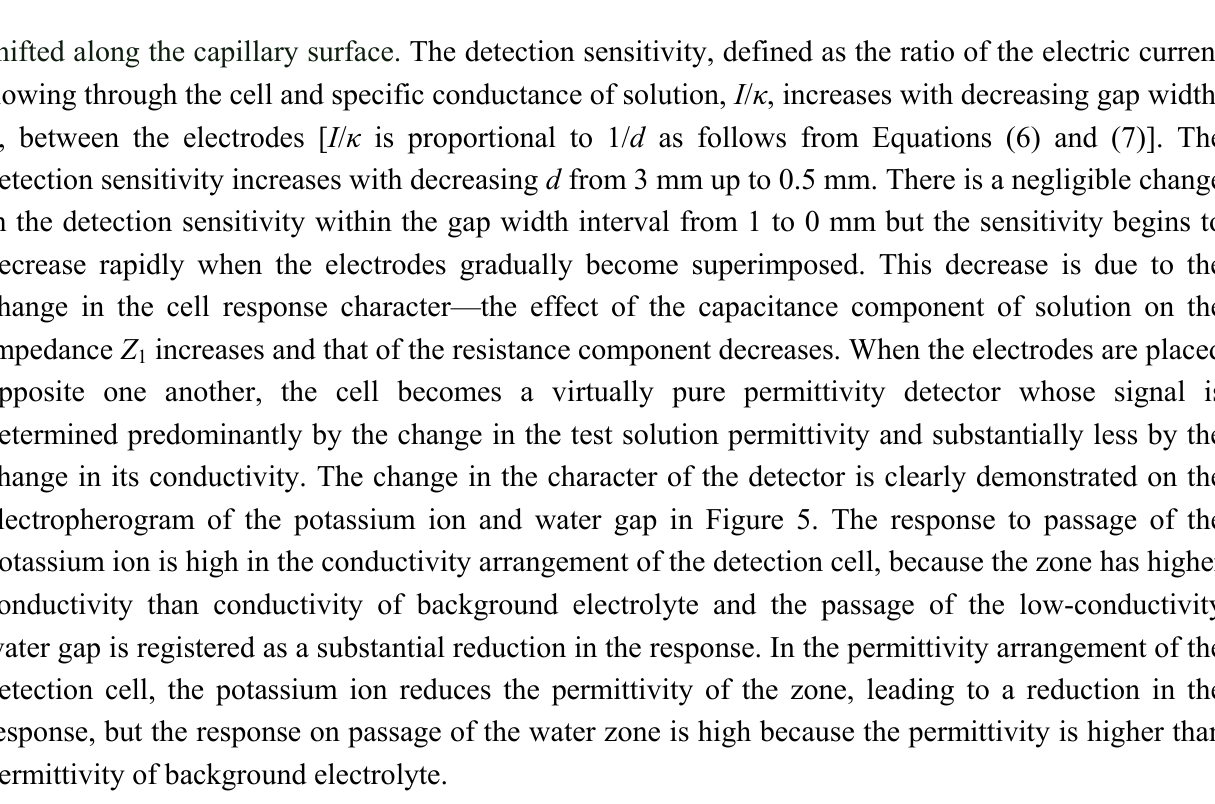
Figure 5. Electropherogram of K + ( 1 ) ion and water gap ( 2 ) obtained using the detection cell with semi-tubular electrodes placed opposite one another with a 1 mm gap between them, 50 μ M K + ( A , thick line), and with electrodes completely overlapped, 500 μ M K + ( B ). Fused silica capillary, 75 µm i.d., total length/length to detector, 58 cm/50 cm, background electrolyte, 20 mM MES/His, separation voltage/current, 20 kV/11 μ A, hydrodynamic sampling, 10 cm/10 s, C 4 D, 300 kH/4.5 V pp